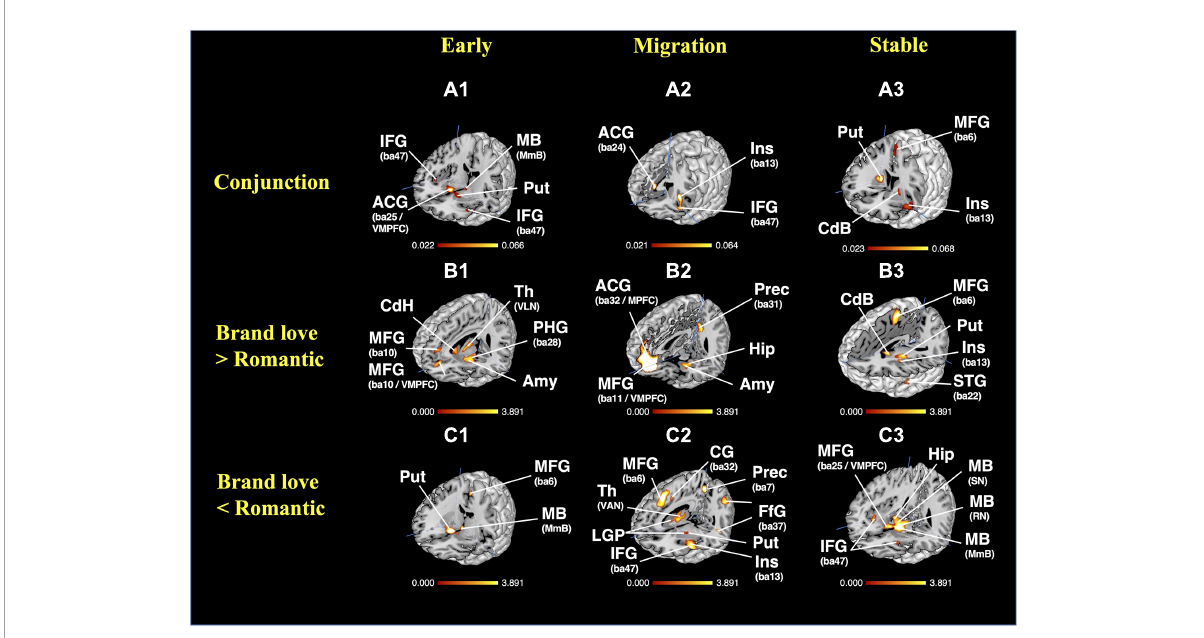
FIGURE8 Results of the conjunction and subtraction analysis. (A) Results of the conjunction analysis; (A1) 3D view of overlapping brain regions in the early stage, crosshair = (44, − 20, − 9); (A2) 3D view of overlapping brain regions in the migration stage, crosshair = (2,17, − 5); (A3) 3D view of overlapping brain regions in the stable stage, crosshair = (27,4, − 4); (B) results of the subtraction analysis (Brand love > Interpersonal romantic love); (B1) 3D view of the distinctive brain regions activated in the early stage brand love relationships, crosshair = ( − 7, − 39, − 14); (B2) 3D view of the distinctive brain regions activated in the migration stage of brand love relationships, crosshair = (1, − 47, − 20); (B3) 3D view of the distinctive brain regions activated in the stable stage of brand love relationships, crosshair = ( − 1, − 54,10); (C) results of the subtraction analysis (Brand love < Interpersonal romantic love); (C1) 3D view of the early stage of interpersonal romantic love relationships, crosshair = (27, − 10, − 13); (C2) 3D view of the migration stage of interpersonal romantic love relationships, crosshair = (11, − 54, − 8); (C3) 3D view of the stable stage of interpersonal romantic love relationships, crosshair = (37, − 45, − 13). BA, brodmann area; ACG, anterior cingulate gyrus; Amy, amygdala; CG, cingulate gyrus; CdB, caudate body; CdH, caudate head; DMPFC, dorsomedial prefrontal cortex; FfG, fusiform gyrus; Hip, hippocampus; IFG, inferior frontal gyrus; Ins, insula; LGP, lateral globus pallidum; MB, midbrain; MmB, Mammillary Body; MFG, medial frontal gyrus; MPFC, medial prefrontal cortex; PCG, posterior cingulate gyrus; PHG, parahippocampal gyrus; PreCG, precentral gyrus; Prec, precuneus; Put, putamen; RN, red nucleus; SFG, superior frontal gyrus; SN, Substania Nigra; Th, thalamus; VAN, ventral anterior nucleus; VMPFC, ventral medial prefrontal